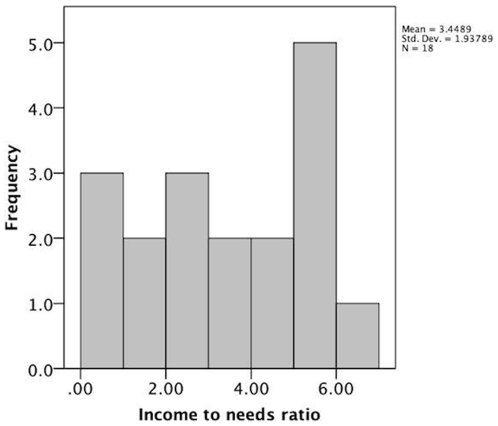
Distribution of income to needs ratio for the parents of children included in this study.